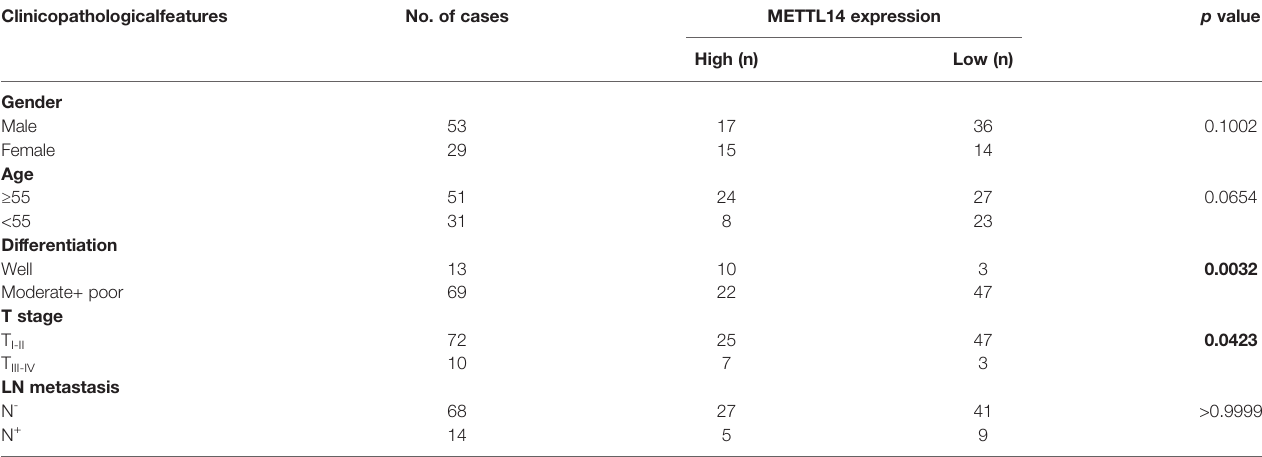
TABLE 1 | Clinicopathological features and METTL14 expression of OSCC